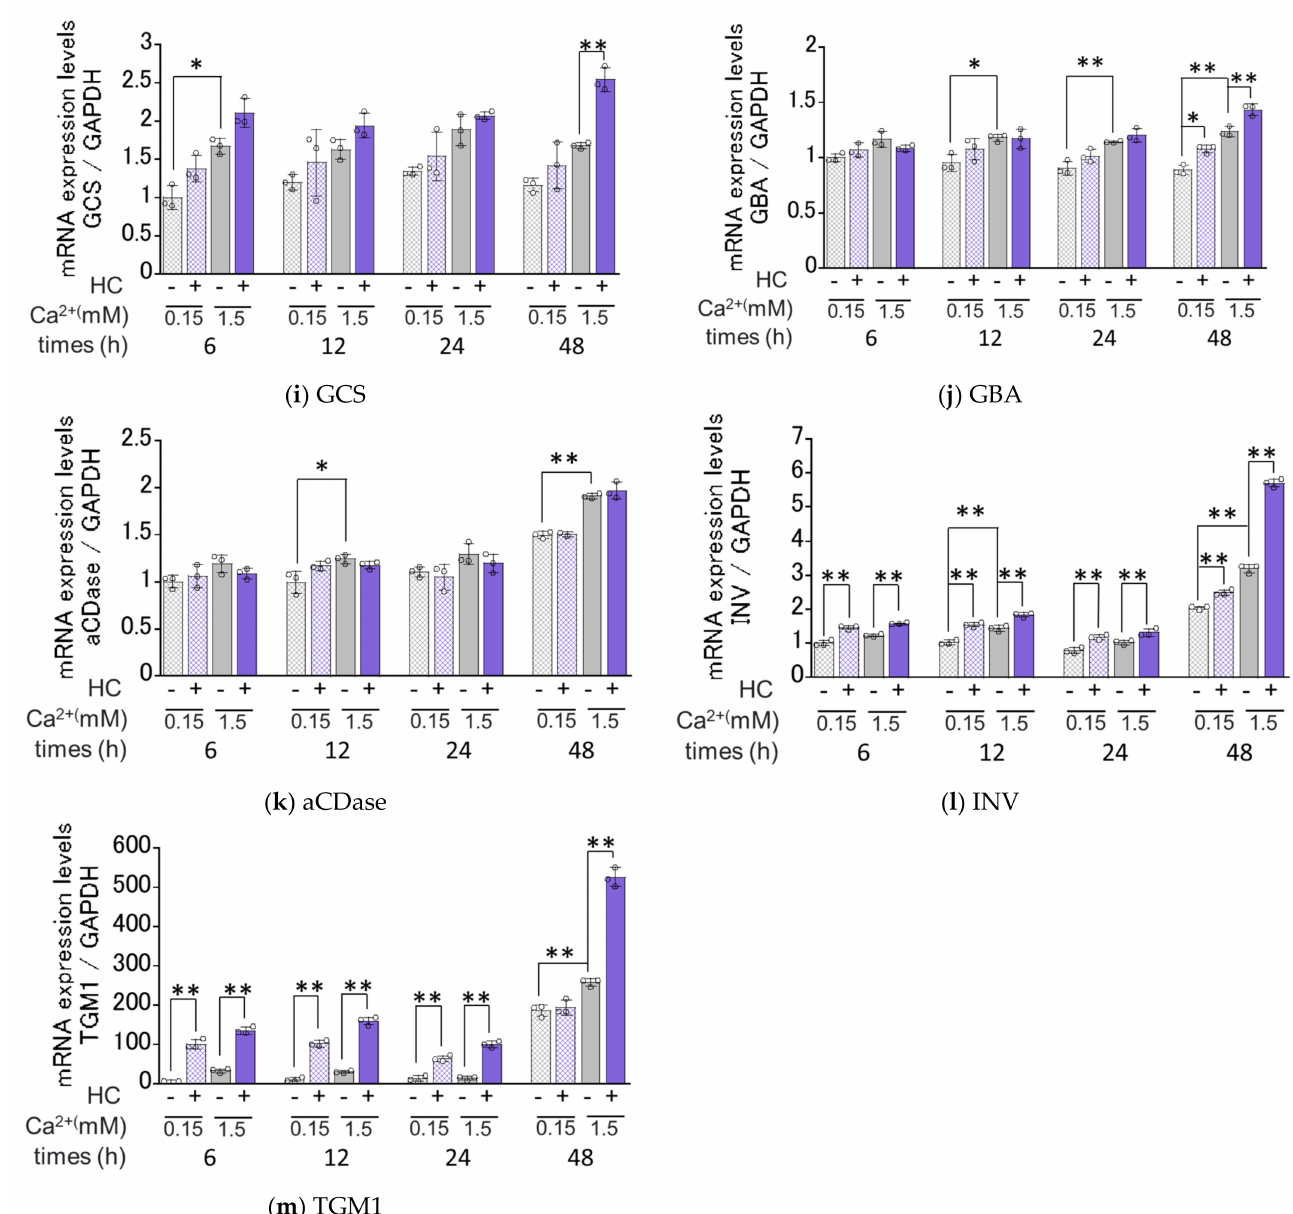
Figure 6. Effect of HC on the expression of ceramide synthesis- and keratinization-related genes in NHKs under proliferating and differentiating conditions. ( a ) SPT1, ( b ) SPT2, ( c ) ELOVL4, ( d ) CERS3, ( e ) DESG1, ( f ) ASM, ( g ) SMS1, ( h ) SMS2, ( i ) GCS, ( j ) GBA, ( k ) aCDase, ( l ) INV, ( m ) TGM1. NHKs were treated with HC (at 0 or 200 µ g/mL) for 6, 12, 24 and 48 h in low-Ca 2+ or high-Ca 2+ conditions, after which total RNAs were extracted as described in the Section 4 Materials and Methods. mRNA expression levels were determined by real-time RT-PCR and are expressed as each mRNA level/GAPDH. Bars represent mean ± SD, n = 3, Tukey–Kramer multiple comparison test. *: p < 0.05, **: p <